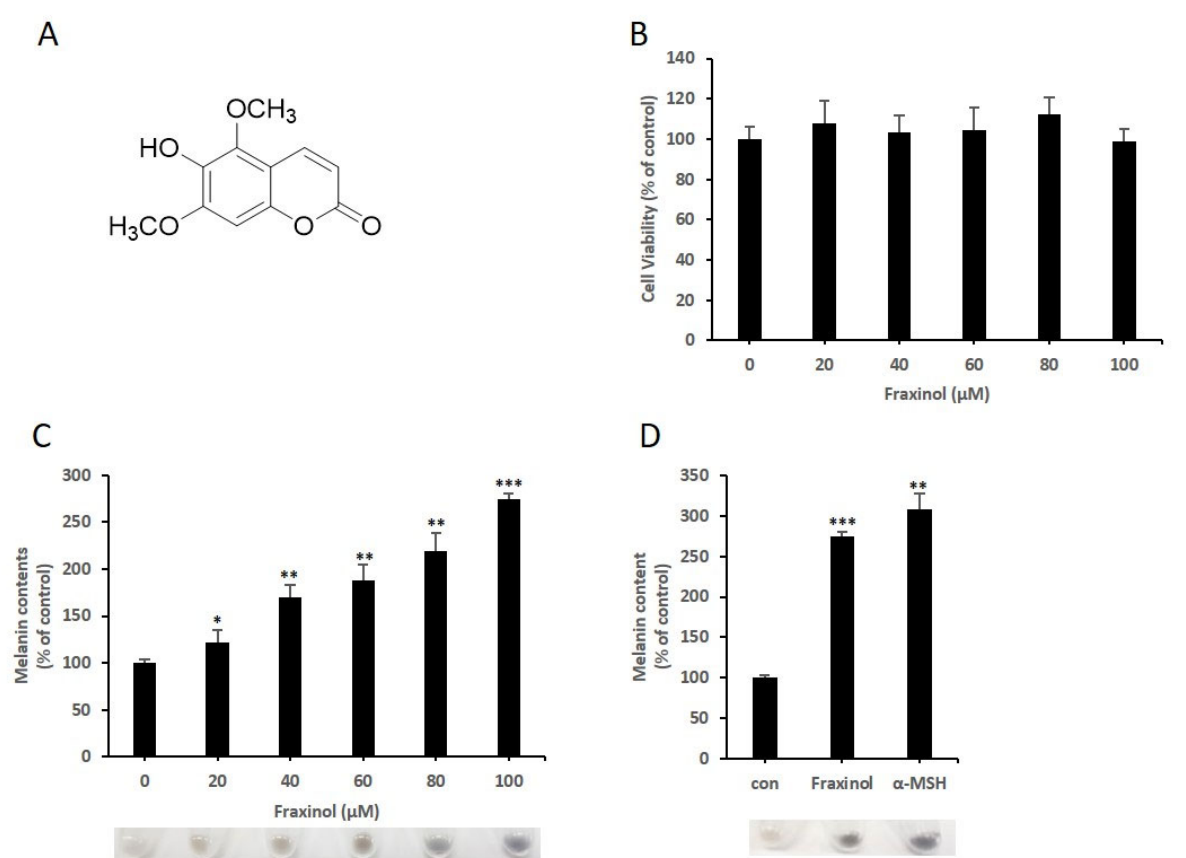
Figure 1. Effects of fraxinol on cell viability and melanin production in B16F10 cells. ( A ) Chemical structure of fraxinol. ( B ) Cytotoxicity of fraxinol in B16F10 cells. Cells were incubated with various concentration of fraxinol (0, 20, 40, 60, 80, or 100 µ M) for 48 h. Cell viability was measured using the MTT assay. The data are shown as the means ± SD; n = 3. ( C ) Effect of fraxinol on melanin accumulation in B16-F10 cells. Cells were treated with fraxinol (0, 20, 40, 60, 80, or 100 µ M) for 48 h. ( D ) Effect of fraxinol and α -MSH on melanin content in B16-F10 cells. Cells were treated with fraxinol (100 µ M) or α -MSH (100 nM) for 48 h. Cellular melanin contents were measured as described in the Materials and Methods section and expressed as percentages compared to the respective value obtained for the control cells (non-treated cells). The data are presented as the means ± SD; n = 3. * p < 0.05, ** p < 0.01, *** p < 0.001 compared to 0 µ M (no